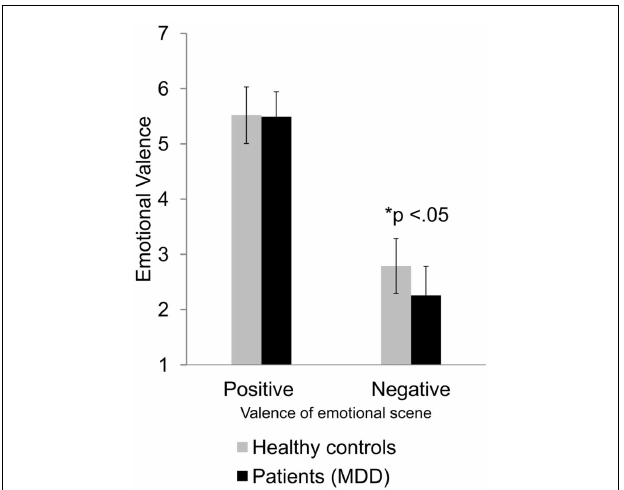
FIGURE 2 | Differences in rating of valence of patients with MDD and healthy controls for positive and negative emotional interactions . Average valence ratings and their standard deviations are displayed as a function of participant group (healthy controls vs. patients with MDD) and valence of depicted emotional scene (positive vs. negative).The difference is significant at the 0.05 level.